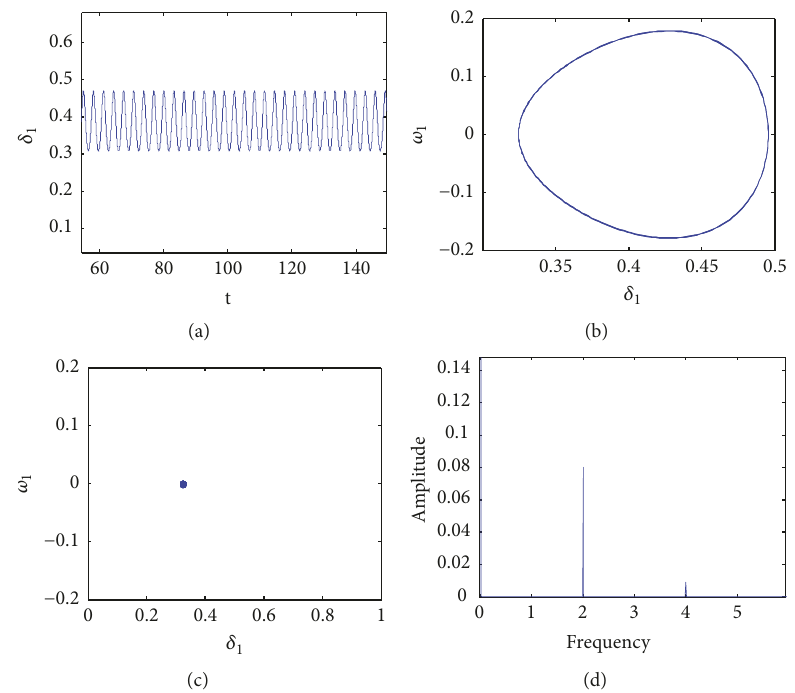
Figure 3: Period 1 motion ( 𝑉 𝐵1 = 0.2 ). (a) Time history. (b) Phase portrait. (c) Poincar´e map. (d) Frequency spectrum.